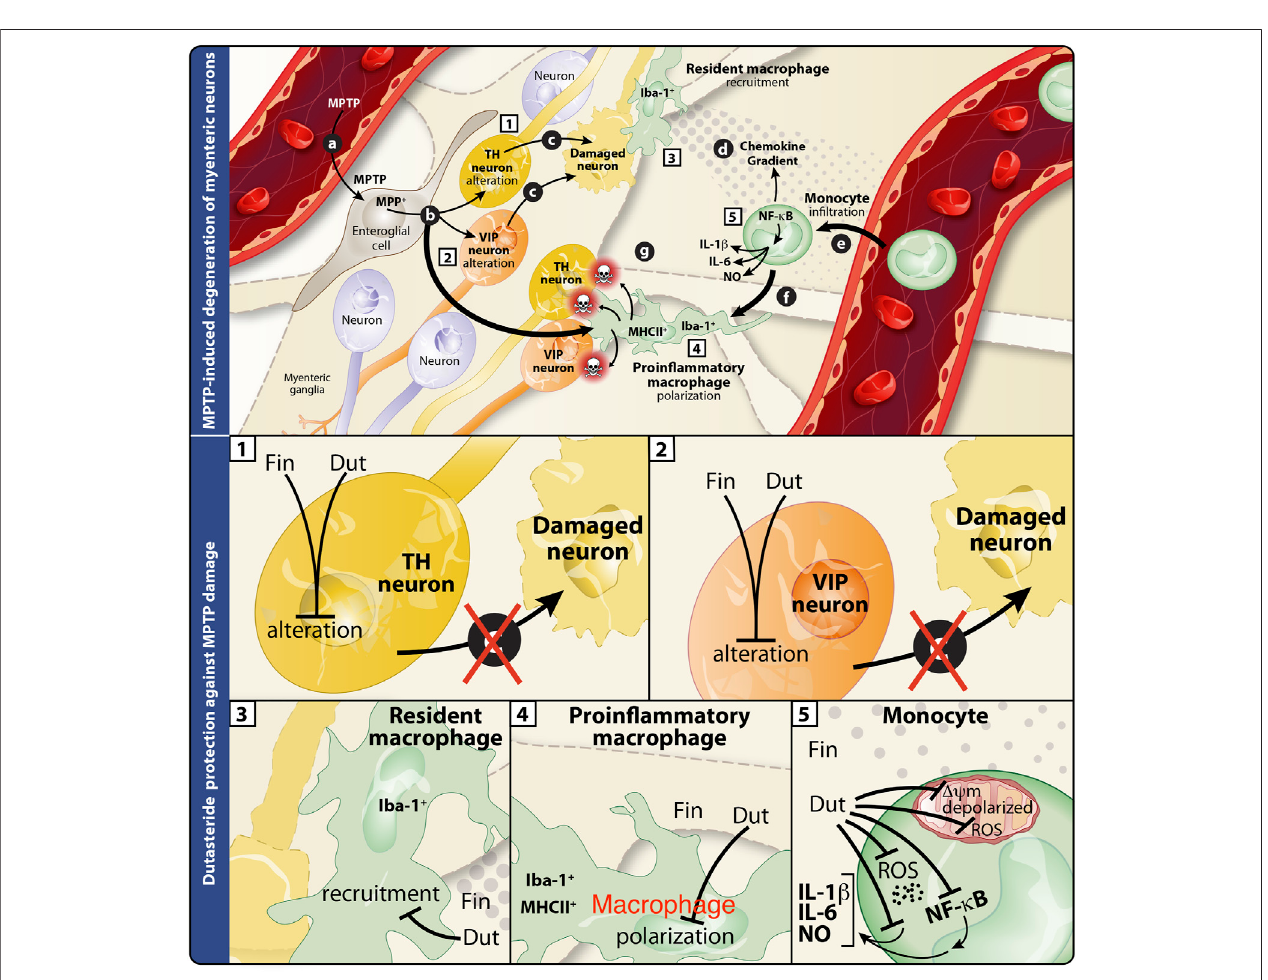
FIGURE 8 | Summary of the effects of fi nasteride and dutasteride in the enteric nervous system of the MPTP mouse model of Parkinson ’ s disease. Schematic interpretationoftheeffectof fi nasteride(Fin)ordutasteride(Dut)treatmentsinthemyentericplexusoftheMPTPmousemodelaccordingtothepresentresults(illustration adapted from Côté et al.,2011). Upper panel illustrates theMPTP-induced damages inthe myenteric plexus (previously investigated in(25)). (A) MPTP enters myenteric gangliaandisprocessedbyenteroglialcellsintoMPP + , (B) thelatterisrecapturedbymacrophagesandleadstoIba-1 + MHCII + proin fl ammatorycellpolarization,or by TH + and VIP + neurons and leads to cell damage (C) . This neuronal damage induces an immune response from Iba-1 + resident macrophages and the release of chemokines (D) . The resulting chemokine gradient promotes the detrimental in fi ltration of monocytes (E) . These events are associated with monocyte differentiation (F) into proin fl ammatory macrophages (Iba-1 + MHCII + ) that may subsequently induce neuronal damage (G) . Lower panels are close-ups of the individual effects of fi nasteride or dutasteride in each cell type studied. (1) MPTP-induced TH + neuron alteration is completely inhibited by fi nasteride and dutasteride treatments. (2) Finasteride and dutasteride inhibit VIP + neuron damage. Dutasteride administration inhibits both Iba-1 + resident macrophage recruitment (3) and Iba-1 + MHCII + proin fl ammatory macrophagepolarization (4) followingMPTP injections, while fi nasteridehad no effect. (5) Finally, dutasteride treatmentcompletely inhibits activationof the NF- κ B transcription factor, cellular production of oxidative stress (ROS), production of the proin fl ammatory cytokines IL-1 β and IL-6, mitochondrial membrane depolarization, and mitochondrial free radical production (ROS) in monocytes. The arrows indicate the consequences of administering MPTP, while the closed ended lines show an inhibition of the